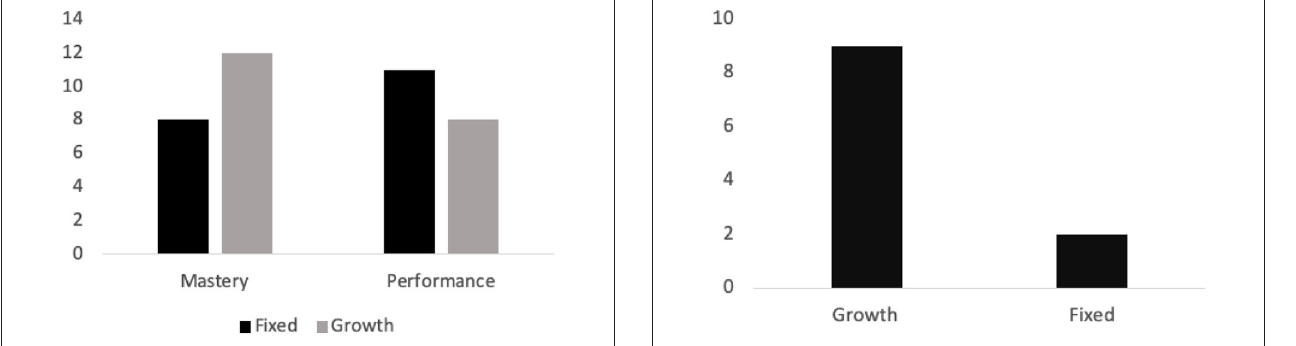
FIGURE 1 | Frequency of mastery vs. performance goal orientations across participants with fixed vs. growth mindset.